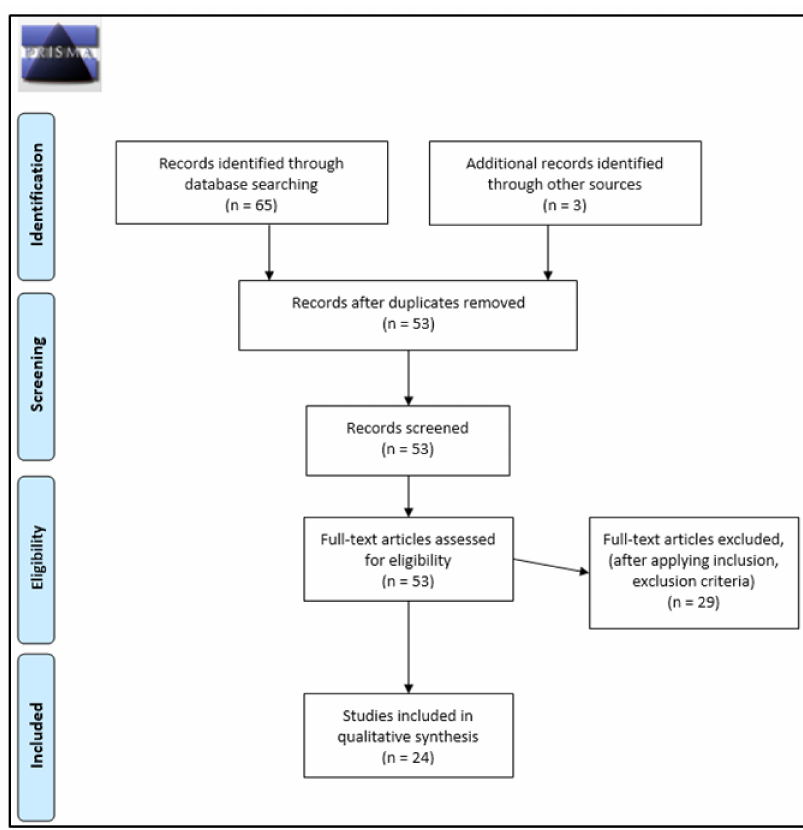
Figure 1. PRISMA 2009 protocols flow